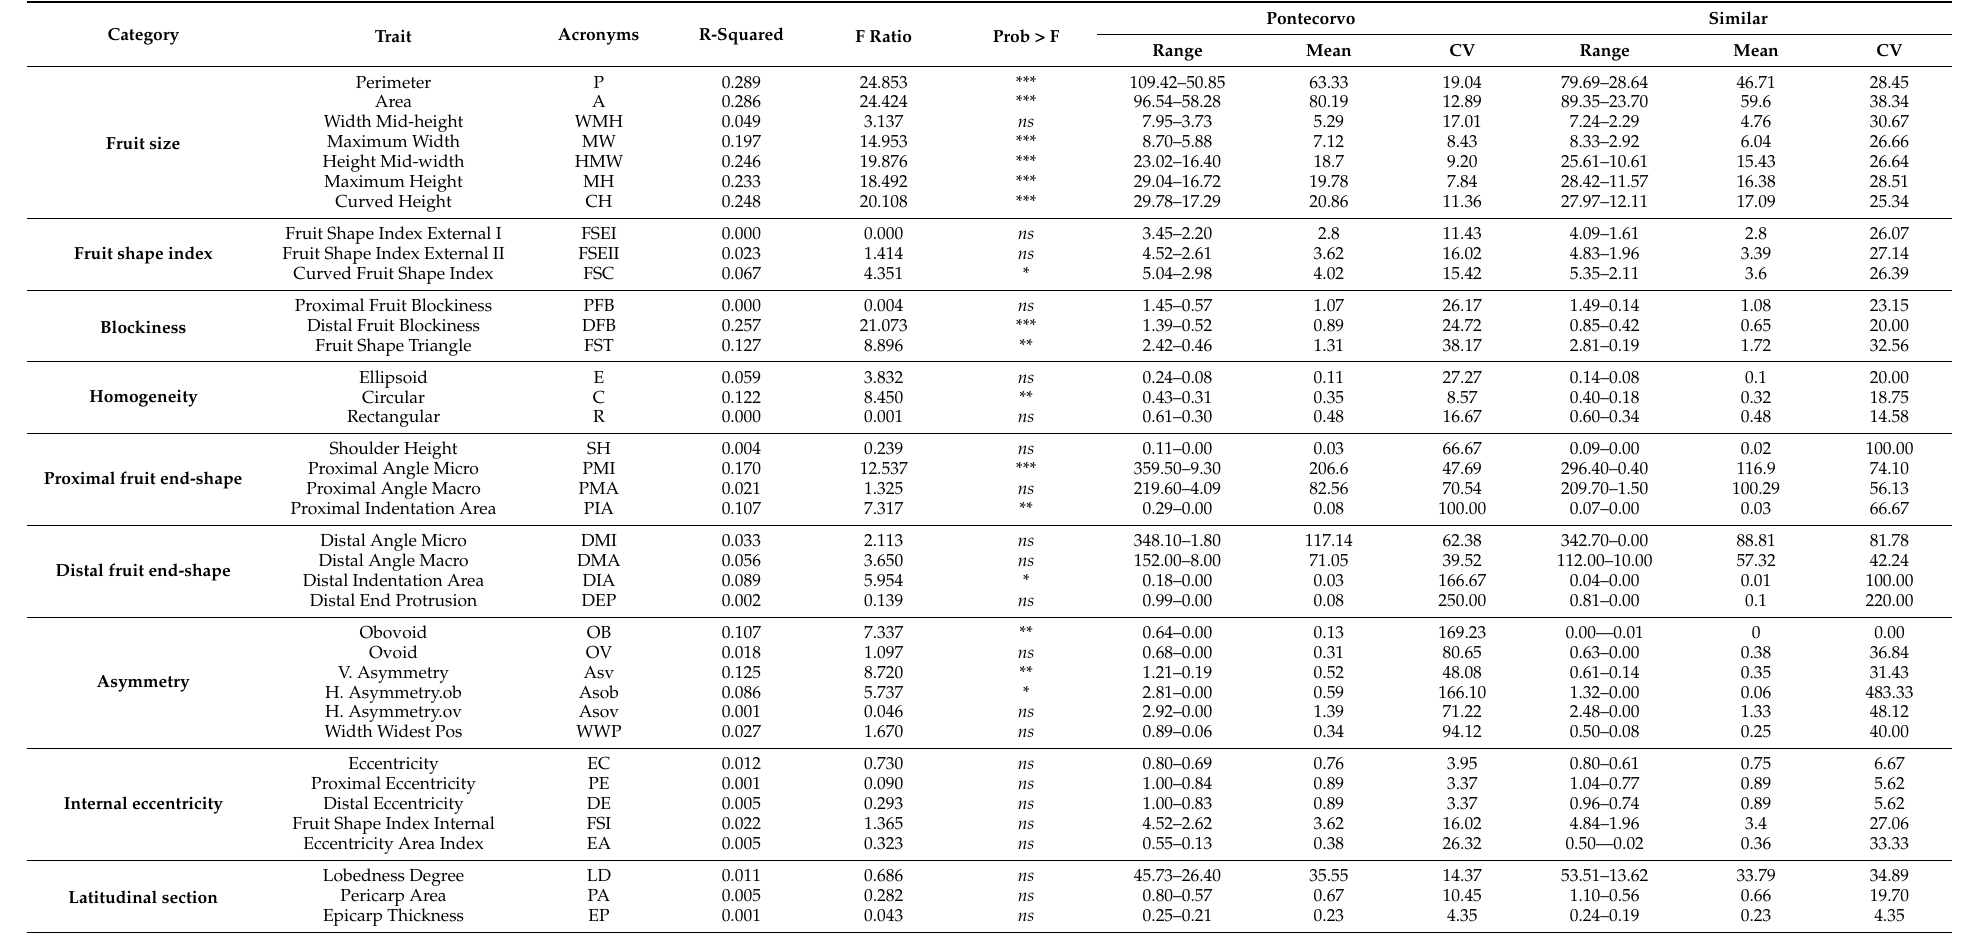
Table 4. MANOVA descriptive statistics, range, mean, and coefficient of variation (CV) for fruit parameters assessed through scans and imaging analysis in the CP accessions and similar